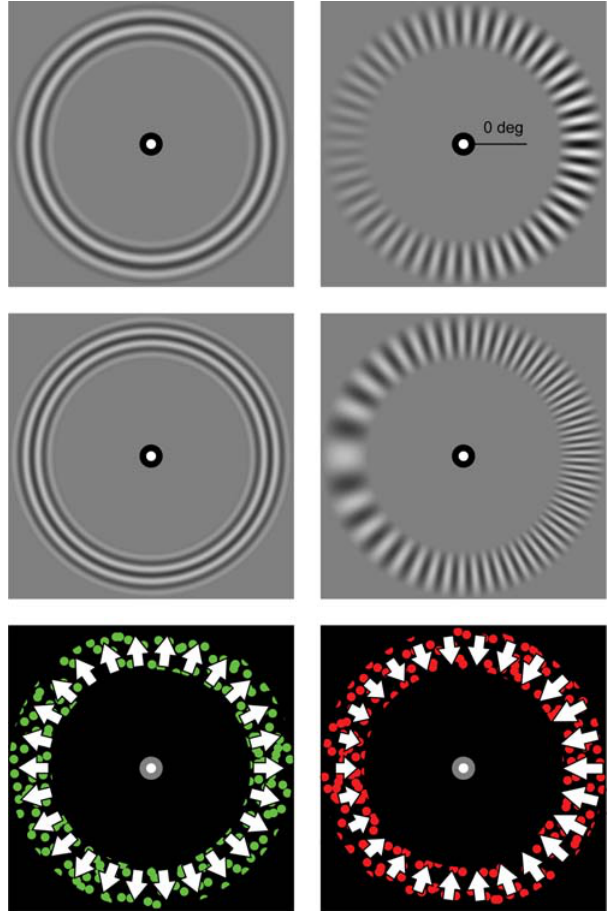
Figure 1. Stimuli used in the three experiments. The top row depicts the stimulus used in Experiment 1 (contrast), the middle row the stimulus in Experiment 2 (spatial frequency) and the bottom row the stimulus in Experiment 3 (motion speed). For each row, the left image was presented to one eye, the right image to the other (the presentation was counterbalanced). In each of the experiments, the parameter under study was constant in one image (the CONST image; left column), while the parameter was varied in the other image (the VAR image; right column). The upper right image indicates the 0 deg